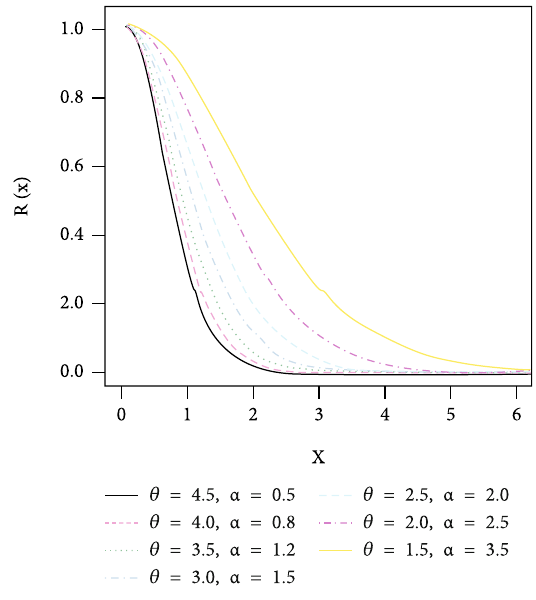
Figure 5: The R function of DWQLD.